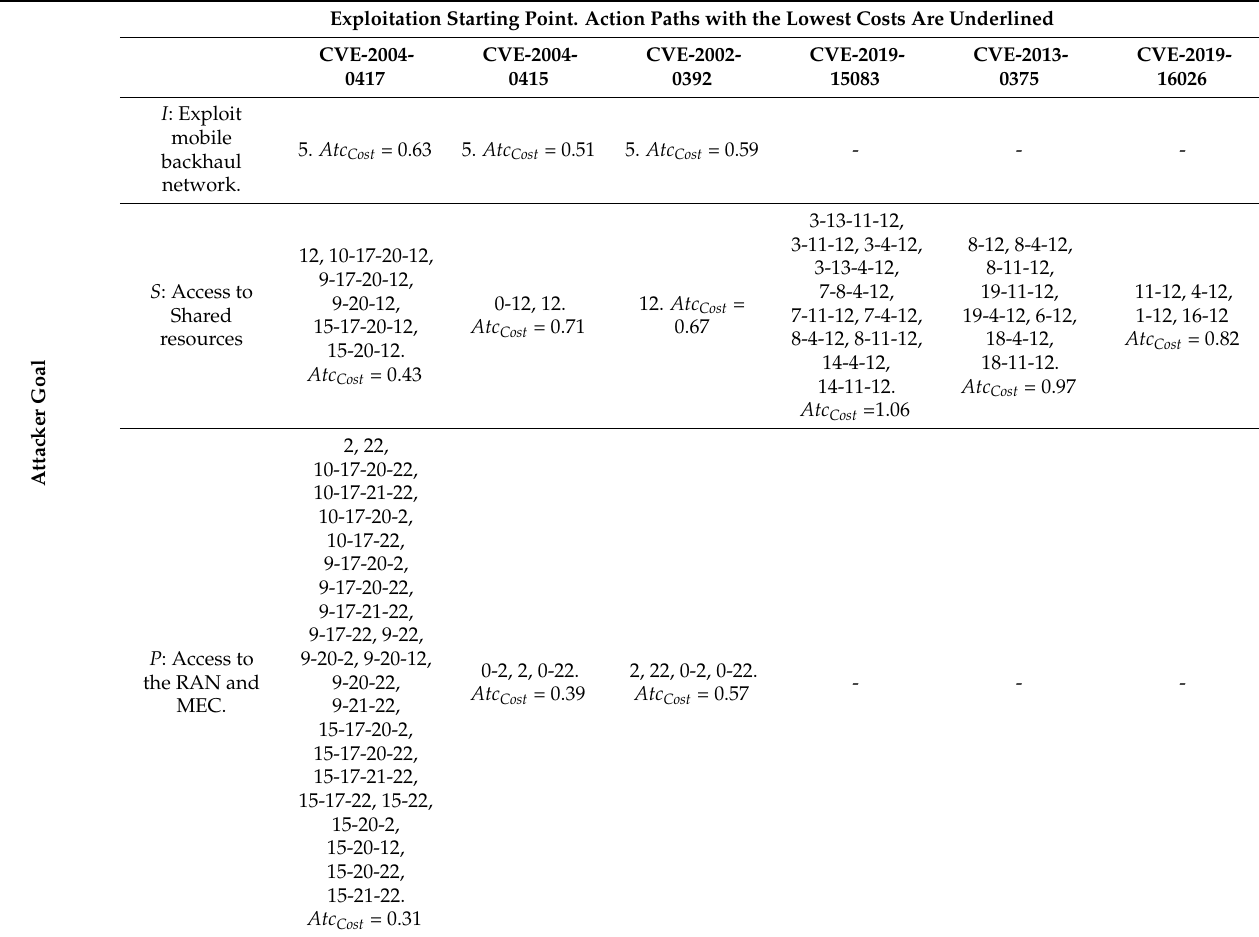
Table 4. Attacker cost in three attacking schemes ( I , S , P